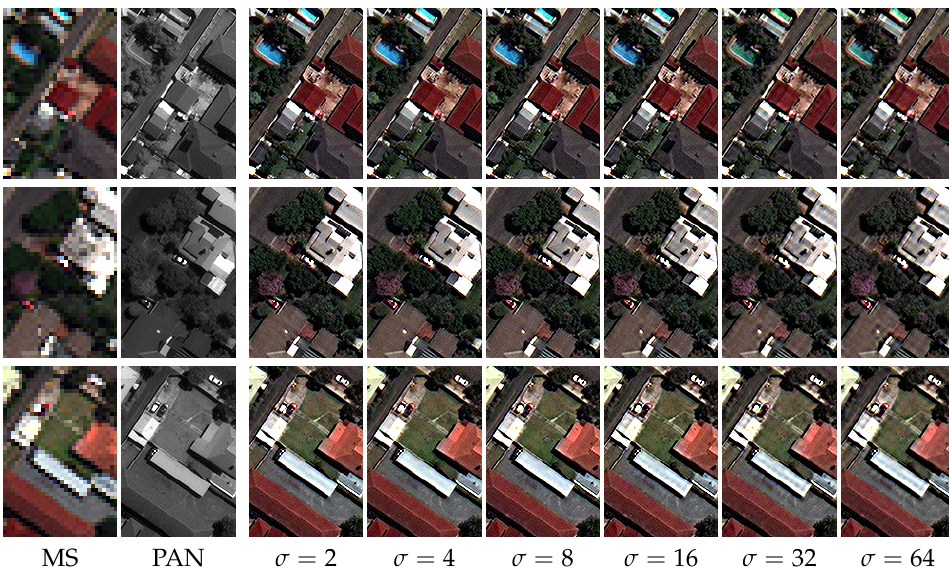
Figure 8. Pansharpening results with controlled spectral ( (cid:96) 1 -norm) and spatial ( D ρ ) distortions. From left to right: MS and PAN, followed by the outputs optimized using σ